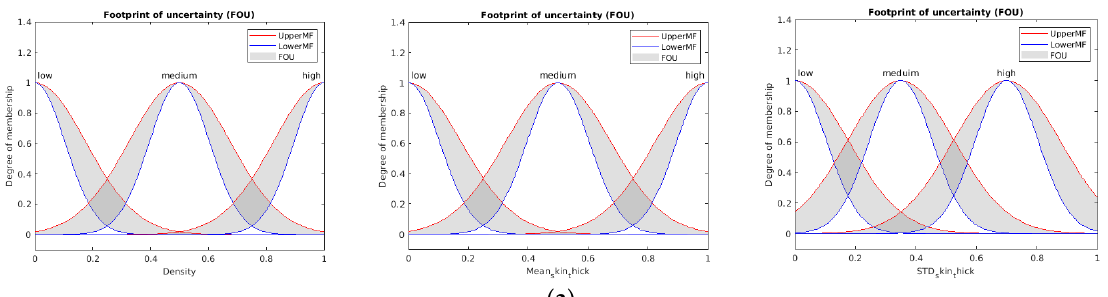
Figure 11. The architecture of the proposed Type-2 fuzzy inference system.